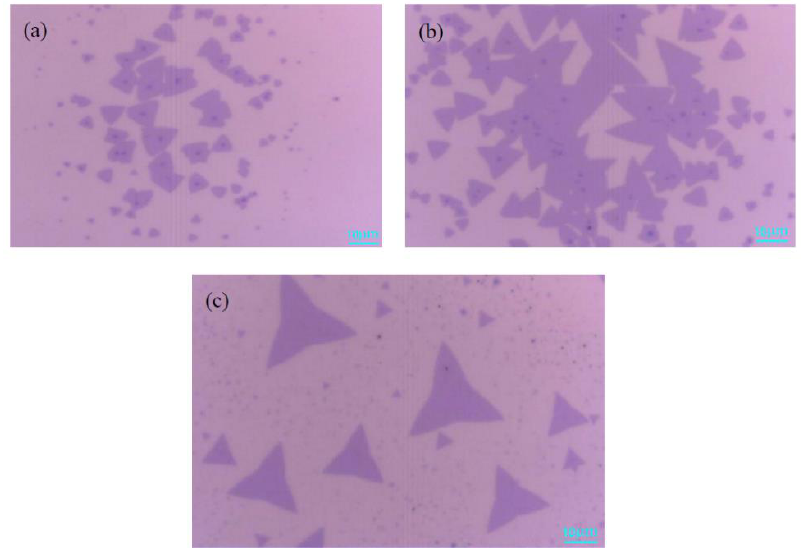
Figure 4. Optical microscope images of MoS 2 with the different mass of S powder ( a ) 50 mg; ( b ) 100 mg; ( c ) 150 mg. Scale bar: 10 μm .